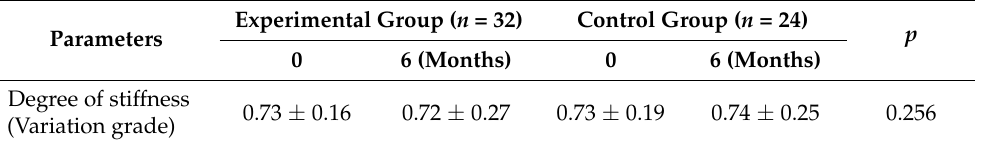
Table 1. Abdominal blood vessels of the experimental group (FIR patients) and control group (non-FIR patients).